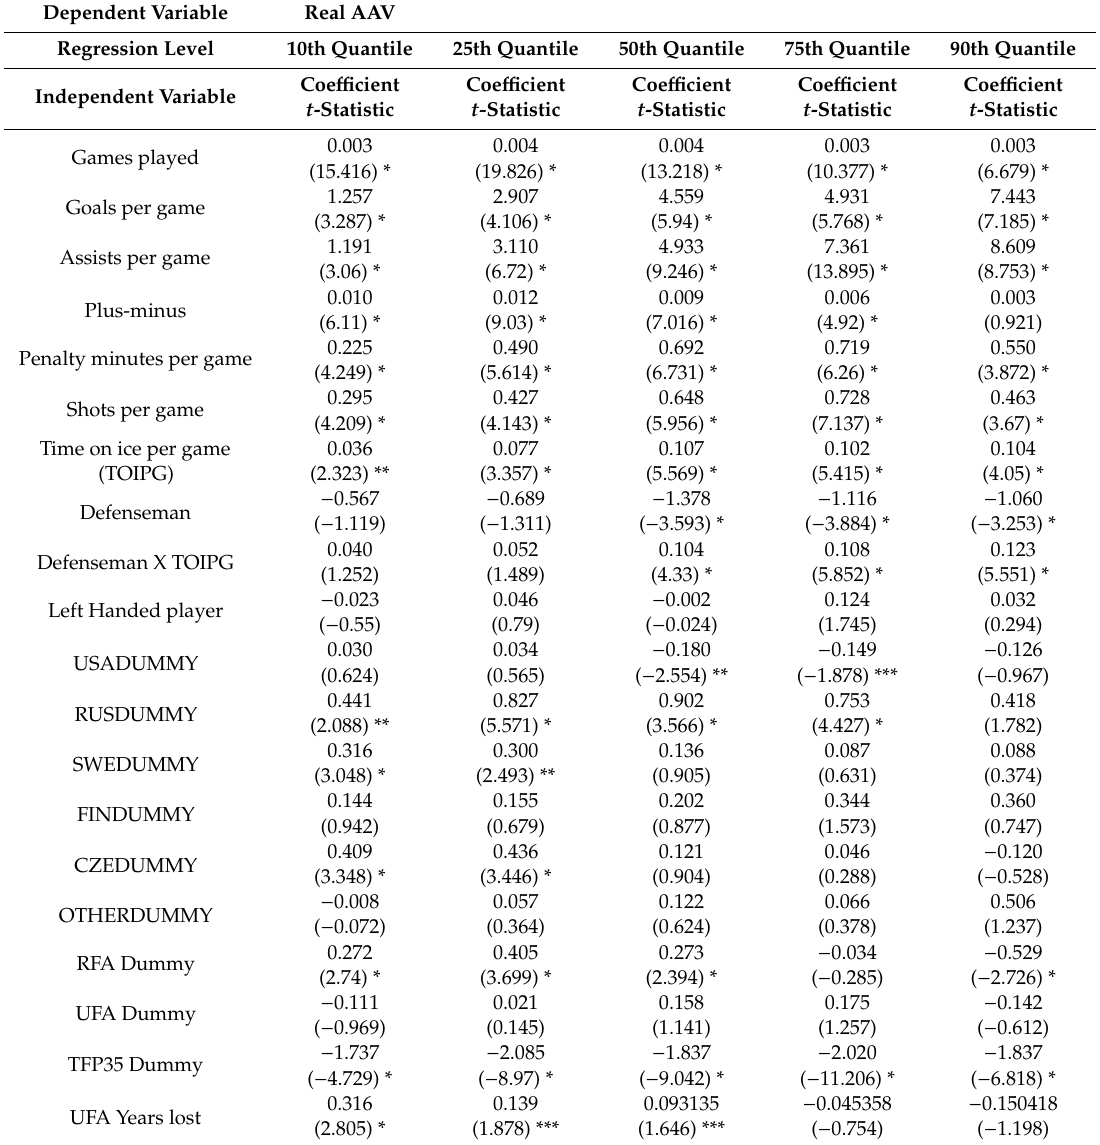
Table 3. Quantile regression results based on lagged career